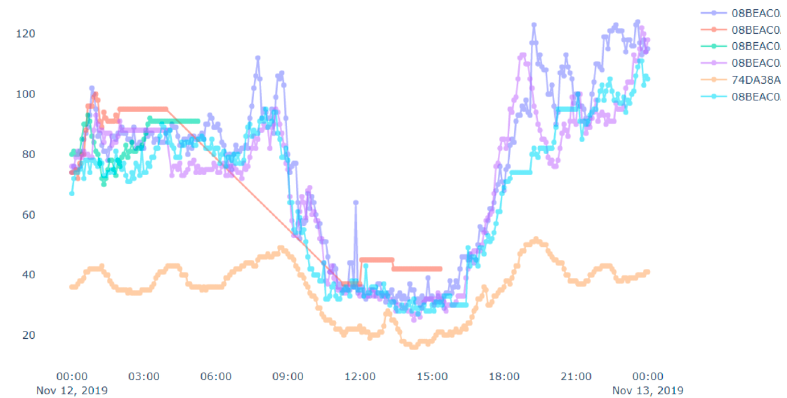
Figure 11. An example of a pollution event.